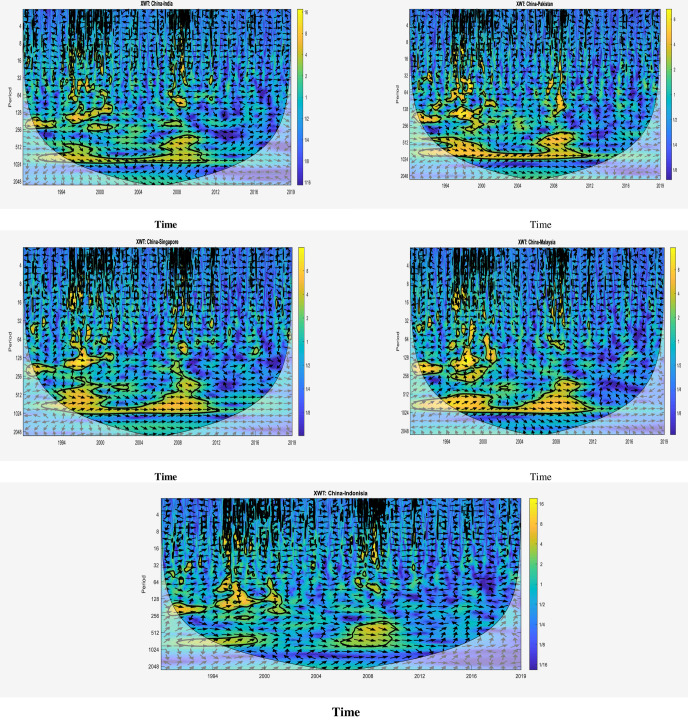
Cross-wavelet power spectra of the emerging stock market.The thick black contour encloses regions where cross-wavelet power spectra is significant at the 5% level against the red noise estimated from Monte Carlo simulations using phase randomized surrogate series. The cone of influence (COI) is indicated by the lighter shade, which delimits the important power regions. The arrows indicate the phase difference between the two time series. The direction of arrows captures the phase difference between two time series. Arrows pointed to the right (left) indicate that variables are in phase (anti-phase), to the right and up (down), the first variable is leading (lagging), and to the left and up (down), the first variable is lagging (leading). Time (year) and frequency (period) are represented on the horizontal and the vertical axis, respectively. The readers can refer to the web version of this article for an accurate interpretation of the graphs.